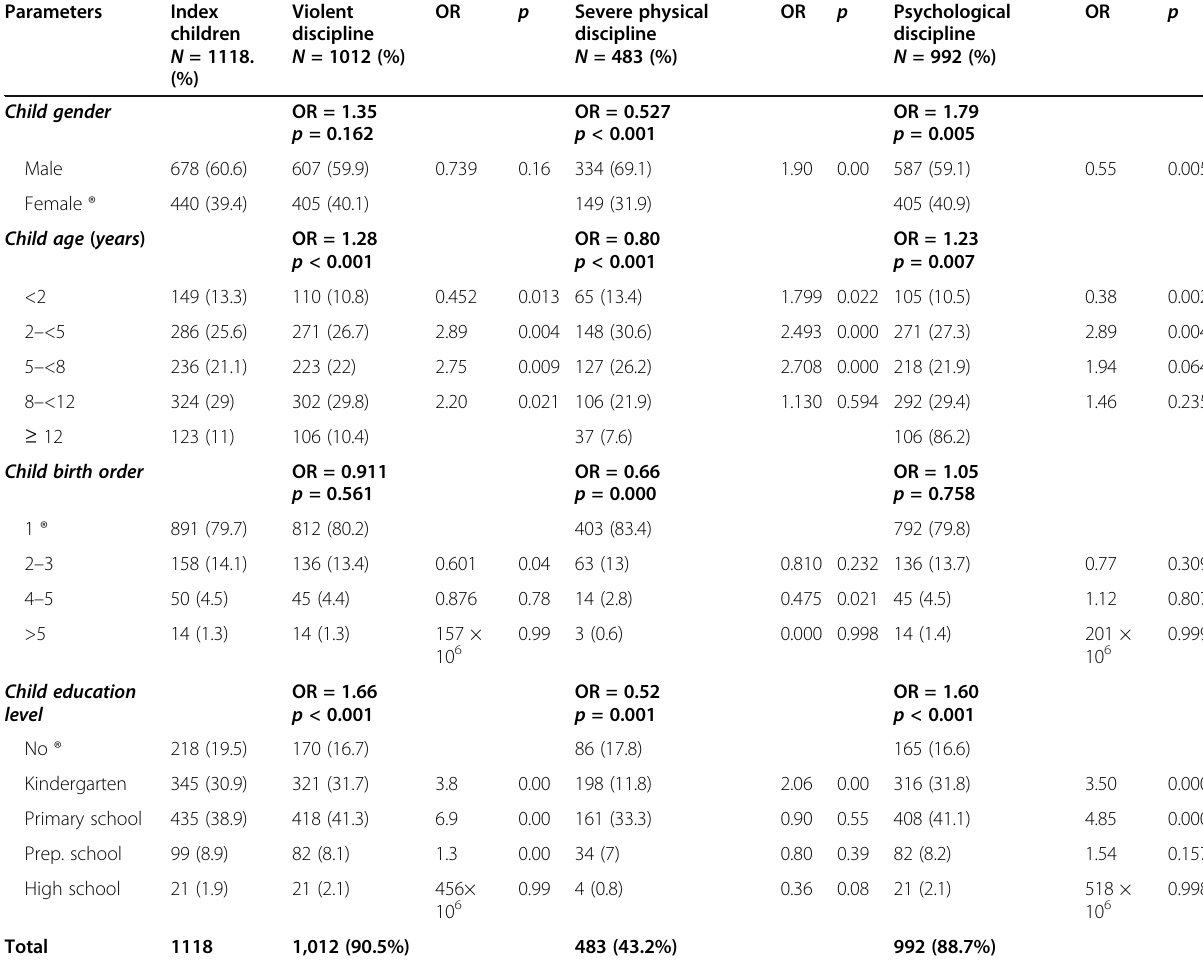
Table 2 Socio-demographic characteristics of children exposed to different types of violent discipline during the COVID-19 pandemic in Sohag governorate, Egypt,